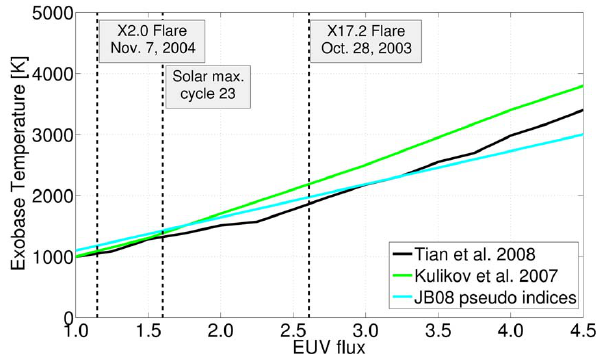
Figure 3. Exobase temperatures obtained from the empirical ther- mosphere model JB08 using the pseudo solar indices and the theo- retical models of Kulikov et al. (2007) and Tian et al. (2008) under different solar EUV